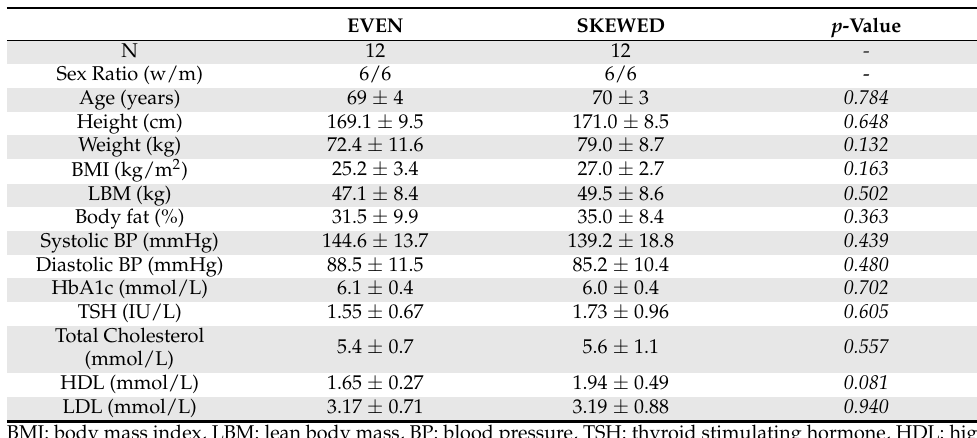
Table 1. Subject characteristics at inclusion.